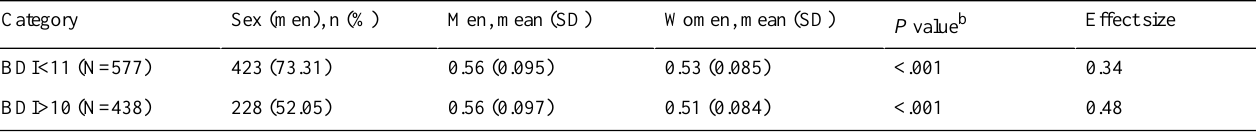
Table 2. Comparison of mean vitality between two groups of men and women according to BDI a score evaluation